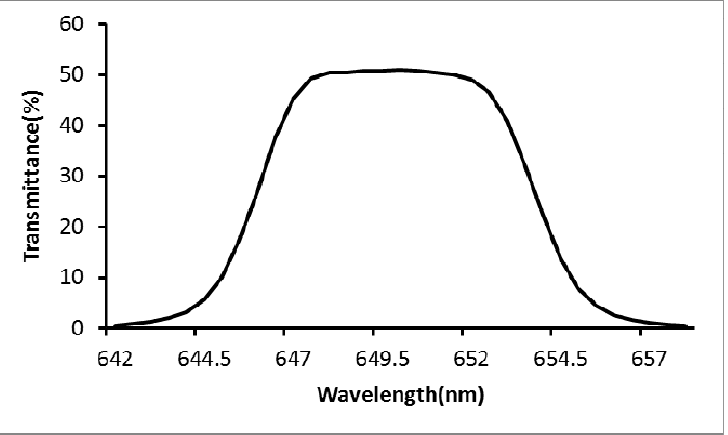
Figure 3. The response curve of the band-pass filter in its